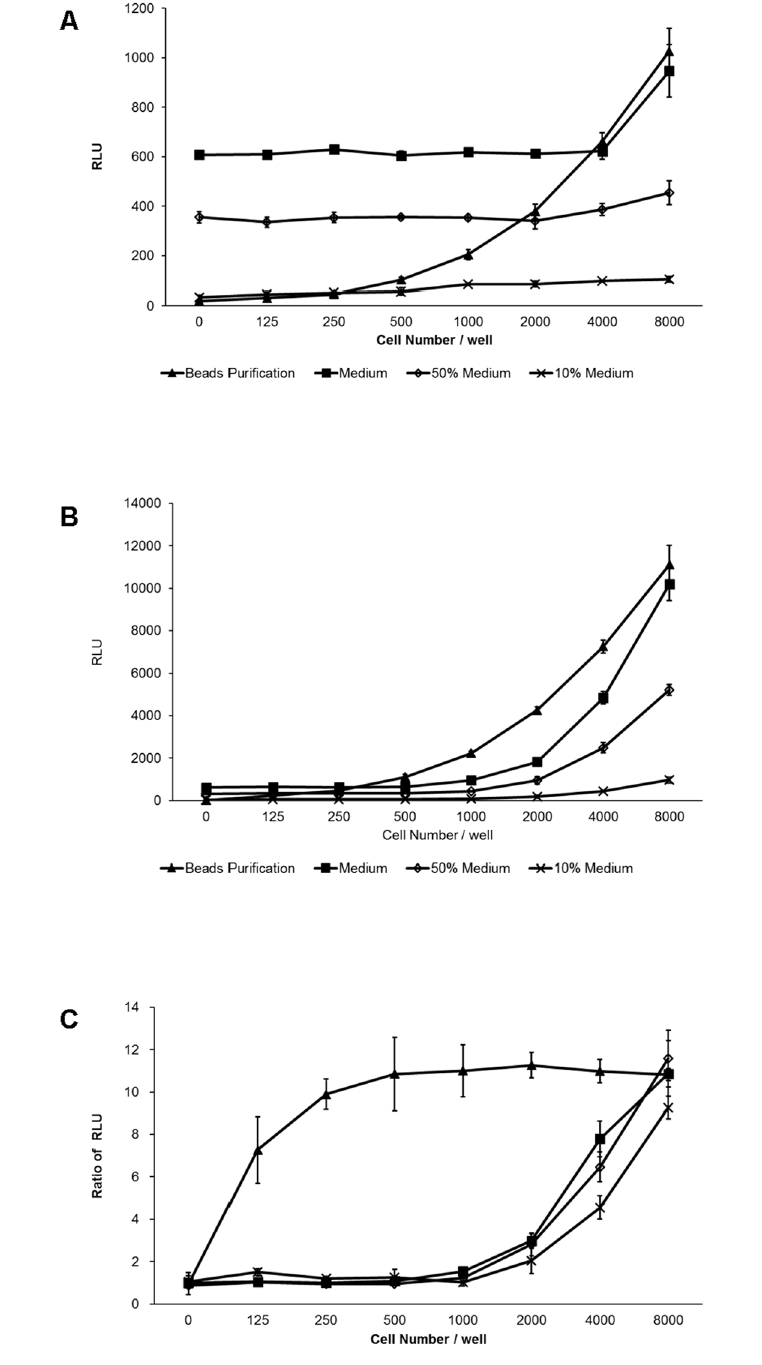
Fig 4. TNF- α -stimulated NF- κ B activation assay. (A) and (B) Measurement of bioluminescence from cells without or with TNF- α stimulation. Monoclonal HeLa cells stably transfected with the NF- κ B-secNluc-FLAG gene were inoculated at different densities (0 to 8000 cells per well) in 24-well plates for 12 h. For TNF- α stimulation, 50 ng/ml TNF- α was added for 12 h to induce the activation of the NF- κ B signaling pathway (B). 100 μ l of each cultured medium was subjected to magnetic bead purification, and the beads were resuspended in 100 μl of PBST. 100 μl of resuspended solution (Beads Purification), 100 μl of cultured medium (Medium), 50 and 10 μl of culture media that were supplemented with PBST to 100 μl (50% Medium and 10% Medium) were used to measure the